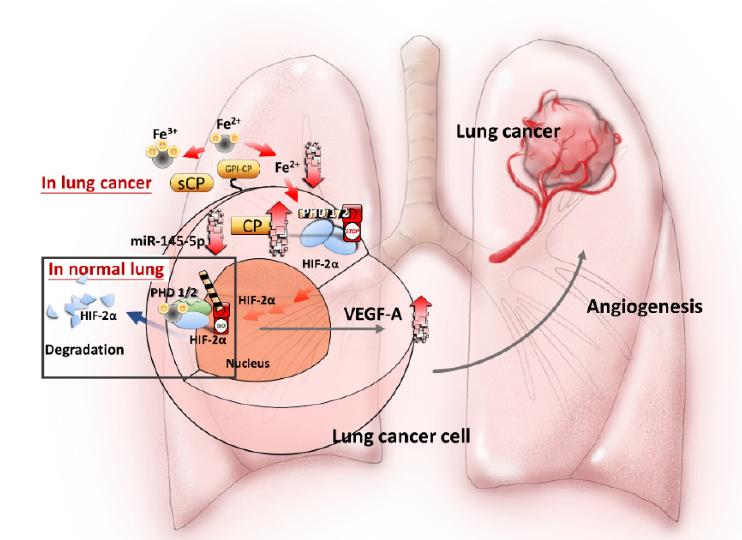
Figure 6. Proposed model of miR-145-5p-CP dysregulation in lung cancer. In normal lung, lower CP (secreted CP (sCP) and glycosylphosphatidylinositol-anchored CP (GPI-CP)) expression leads to ferrous ion (Fe 2+ ) accumulation, PHD 1/2 activation and followed by HIF-2 α degradation. However, in lung cancer, lower miR-145-5p preserves CP, which oxidizes Fe 2+ into Fe 3+ with the consequent inactivation of PHD1/2. The inactivation of PHDs in turn increases HIF-2 α stabilization. The elevated HIF-2 α increases VEGF-A expression, resulting in tumor angiogenesis. Our study provides a new mechanism by which CP dysregulation due to loss of function in miR-145-5p is involved in the angiogenesis in lung cancer.